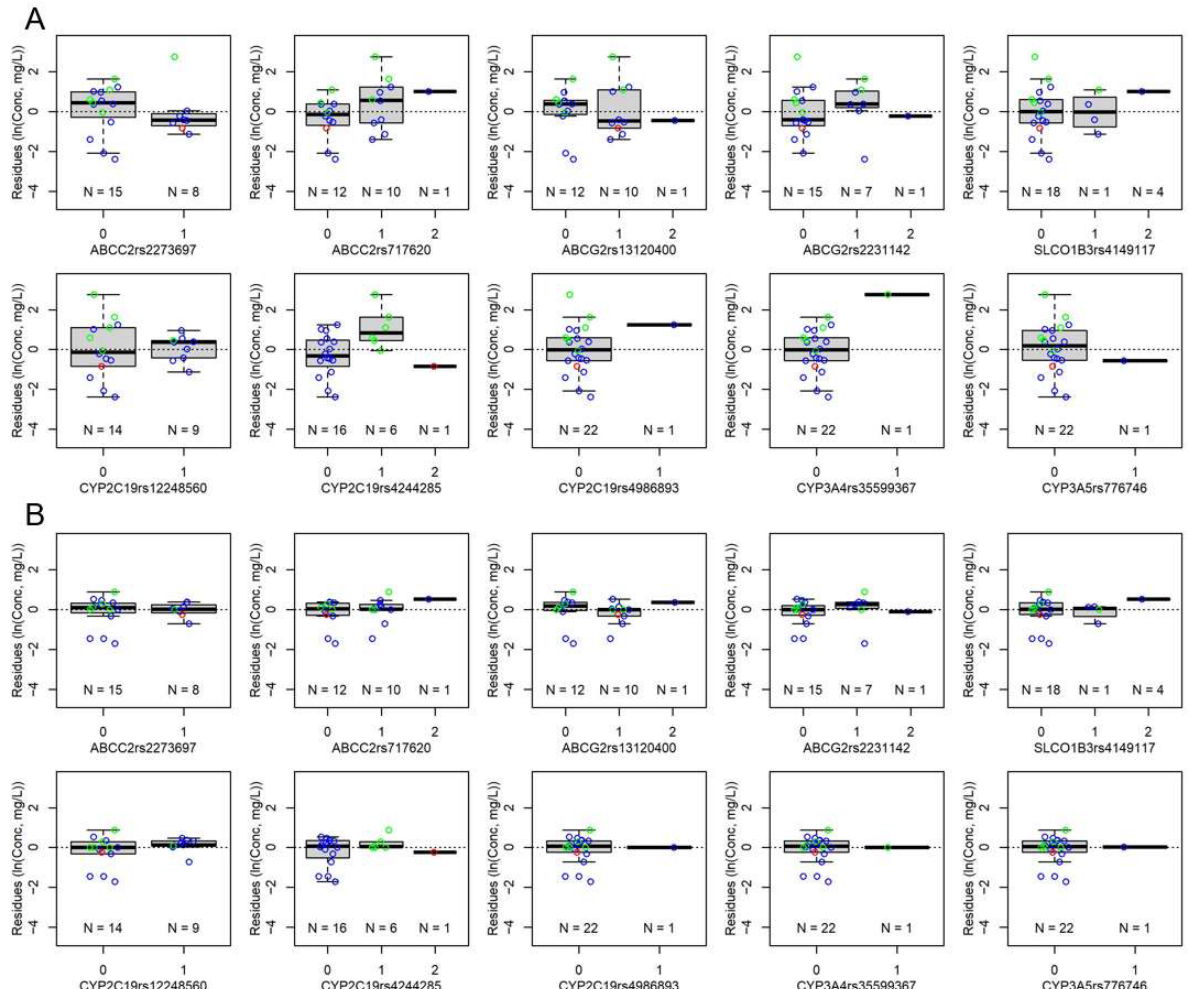
Figure 5. Distribution of the residues of ln( C through ) (observed − predicted) according to the genotypes of the individual patients. ( A ) Before inclusion of covariates for co-medications and genetic variants in the model. ( B ) Final model in Table 4. Both plots, population level (no random effects included). Box-and-whisker plots. Individual data points are superimposed in color. Blue, CYP2C19 rs4244285 GG genotype; green, GA; red, AA. 0, homozygous reference alleles; 1, heterozygous; 2, homozygous variant alleles.